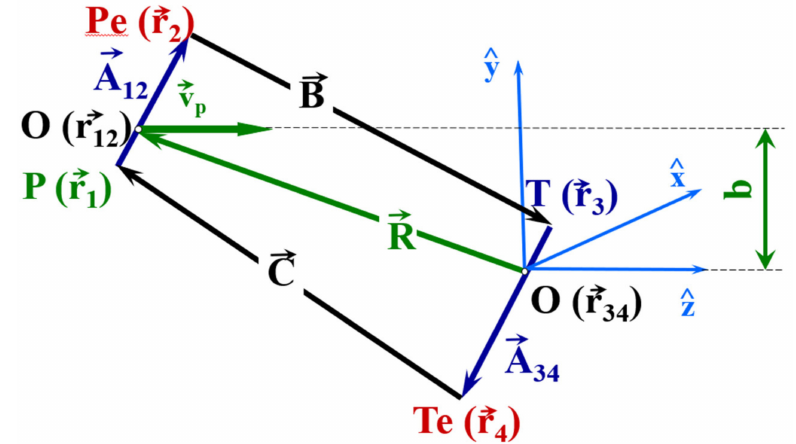
Figure 1. The relative position vectors of the particles involved in four-body